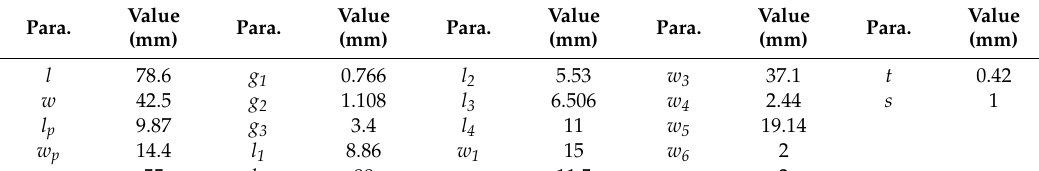
Table 2. Parameter dimensions of the proposed antenna.